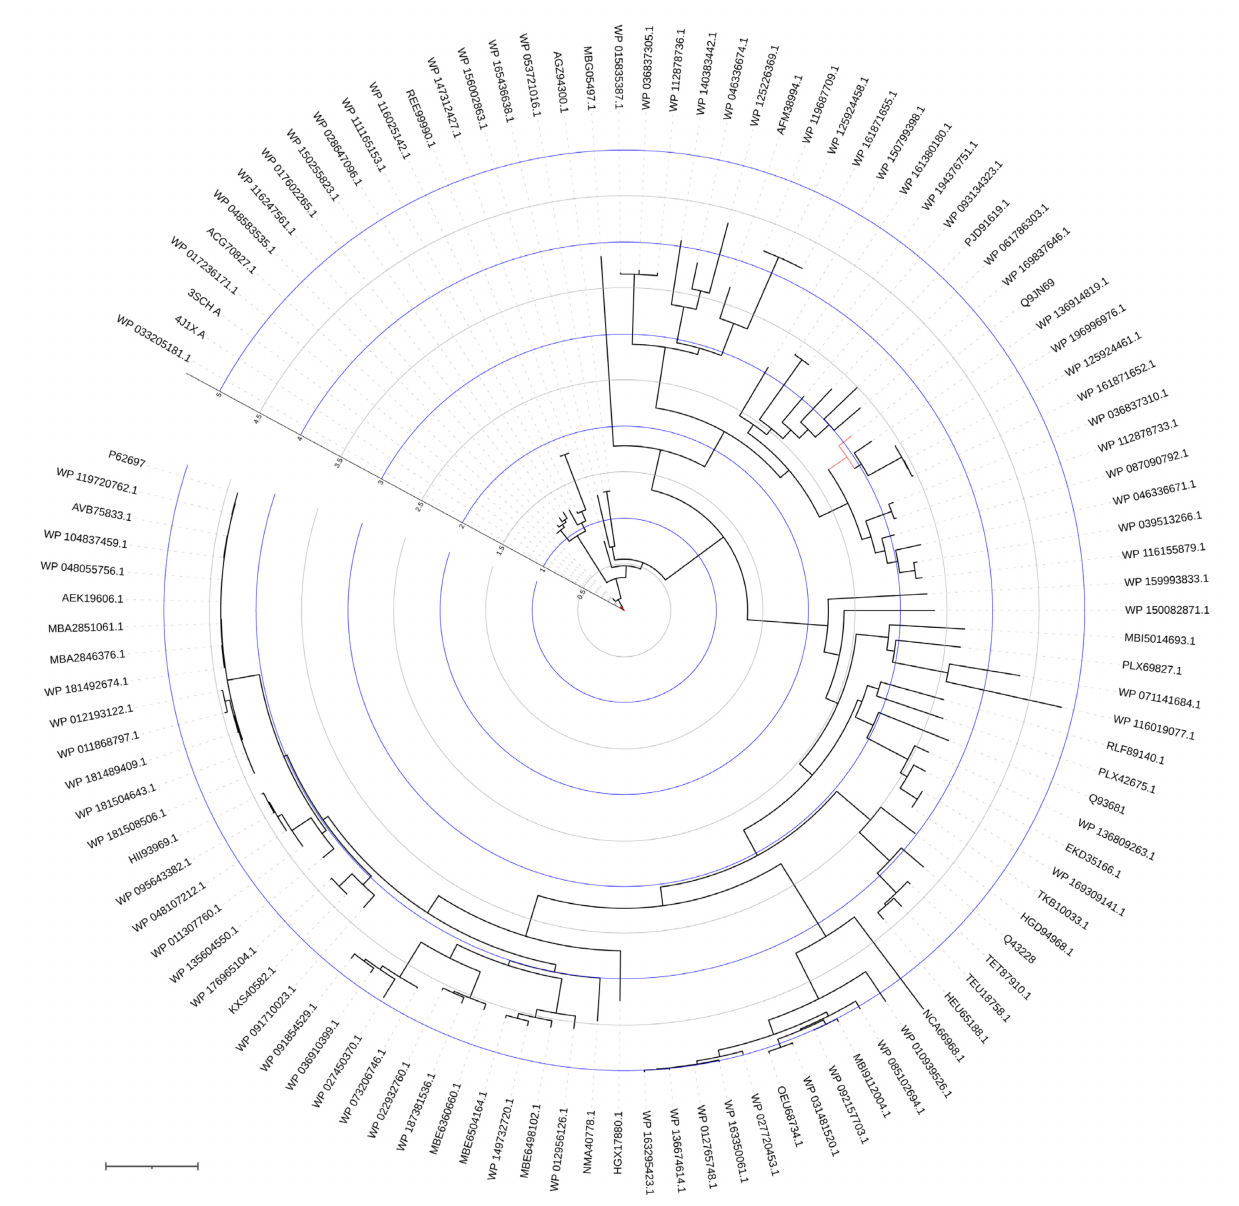
Figure 21. Phylogenetic tree of HppE and its homologous enzymes (down to 25% identity). The tree was built as previously with PDB 5U58 and 3SCF as reference sequences. Enzymes having high (90–100%) identity with 5U58 and 3SCF are highlighted with red and pink,